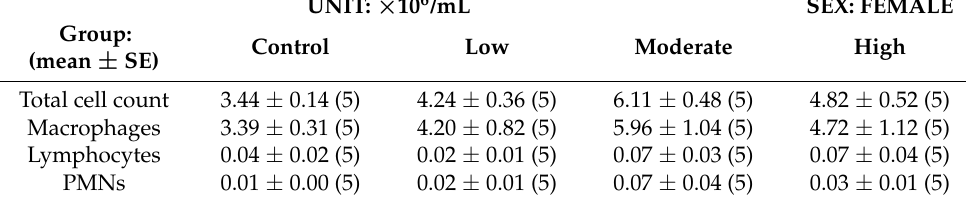
Table 5. BAL differential cell counts at 1, 3, and 21 days after CNF exposure. (A) Males (1, 3, and 21 Days Post-Exposure) Summary of Bronchoalveolar Lavage